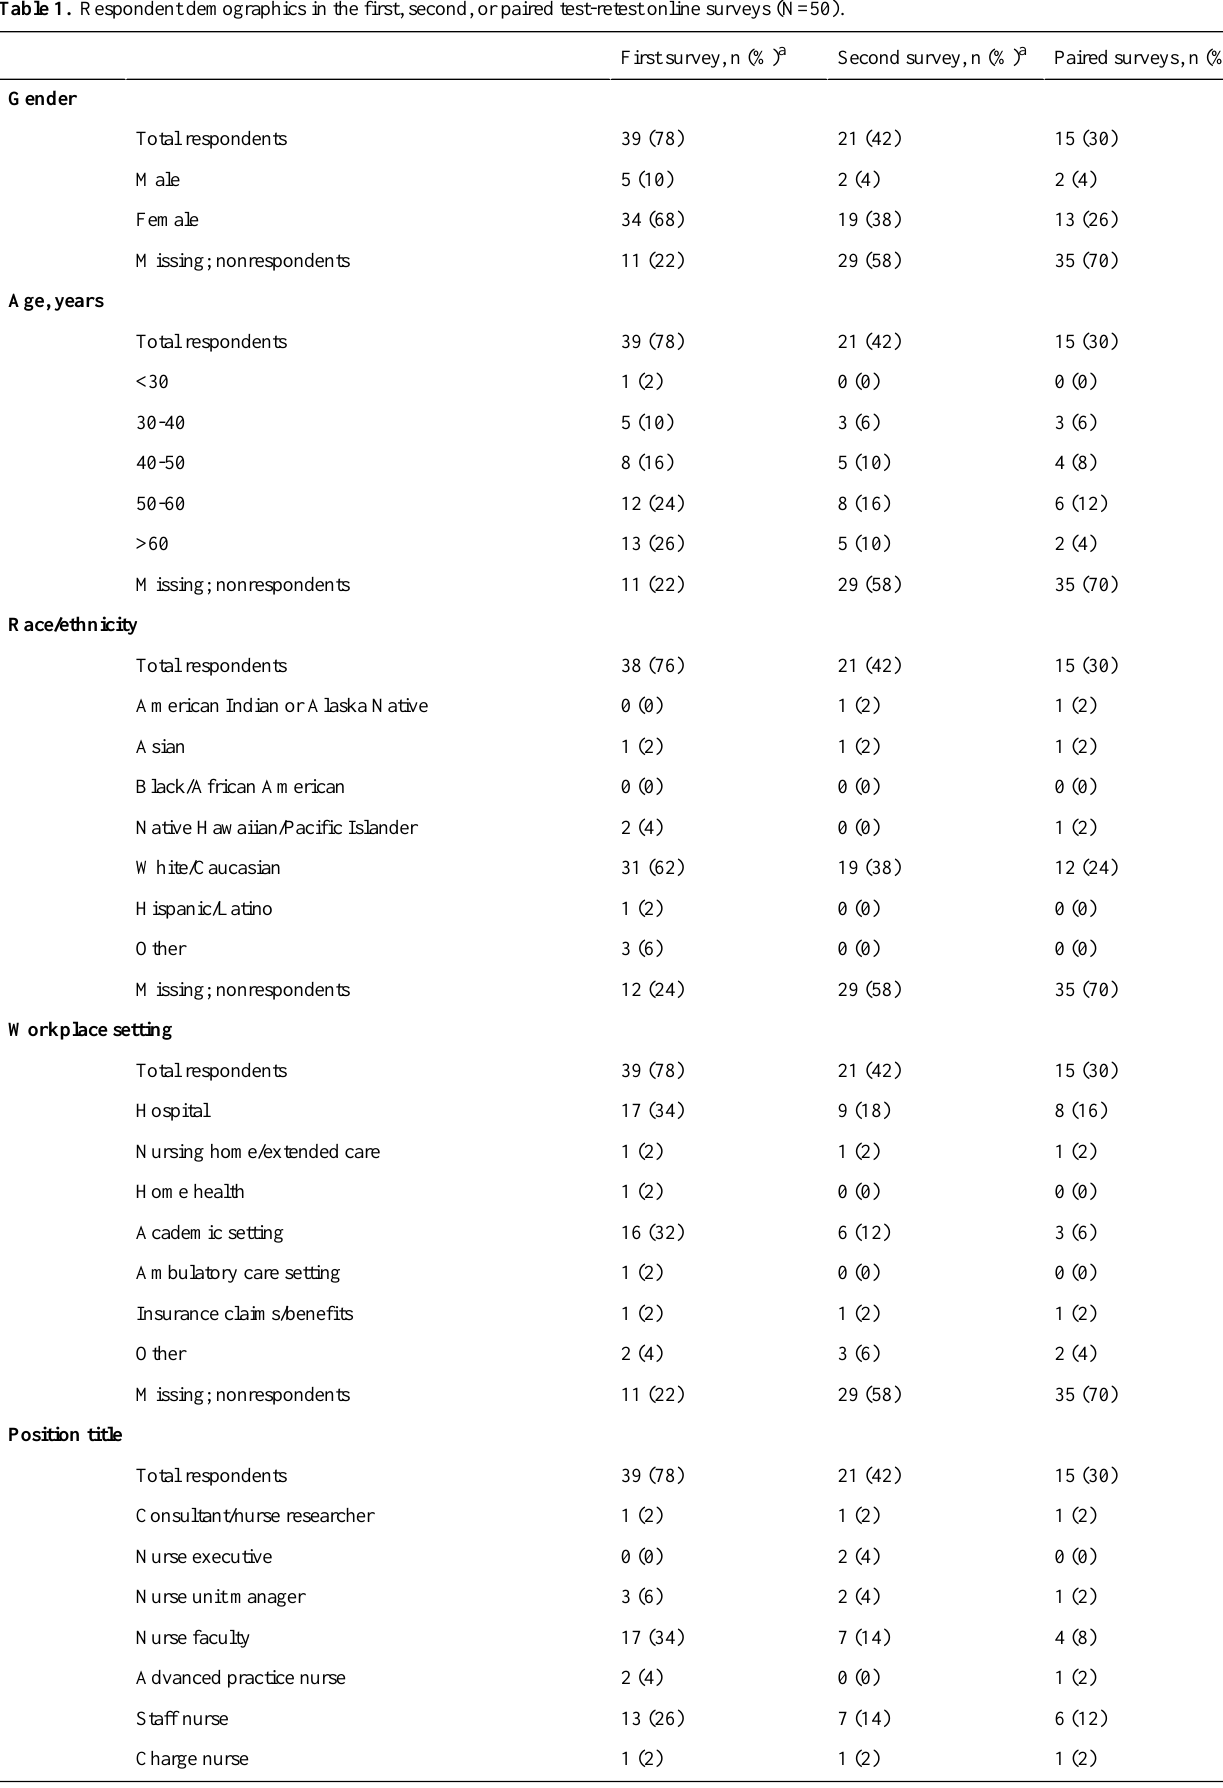
Table 1. Respondent demographics in the first, second, or paired test-retest online surveys